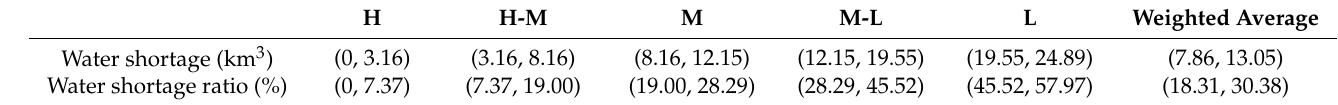
Table 10. Water shortage (Type II) under different incoming flow levels.